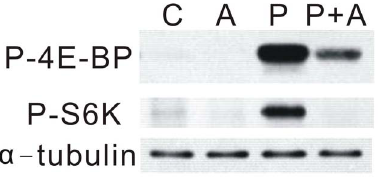
Figure 8. Effects of AICAR on PTTH-stimulated TOR signaling. C, Glands incubated in control medium; P, glands incubated in medium containing PTTH only; A, glands incubated in medium containing 1 mM AICAR only; P + A, glands incubated in medium containing both PTTH and AICAR. Results shown are representative of three independent